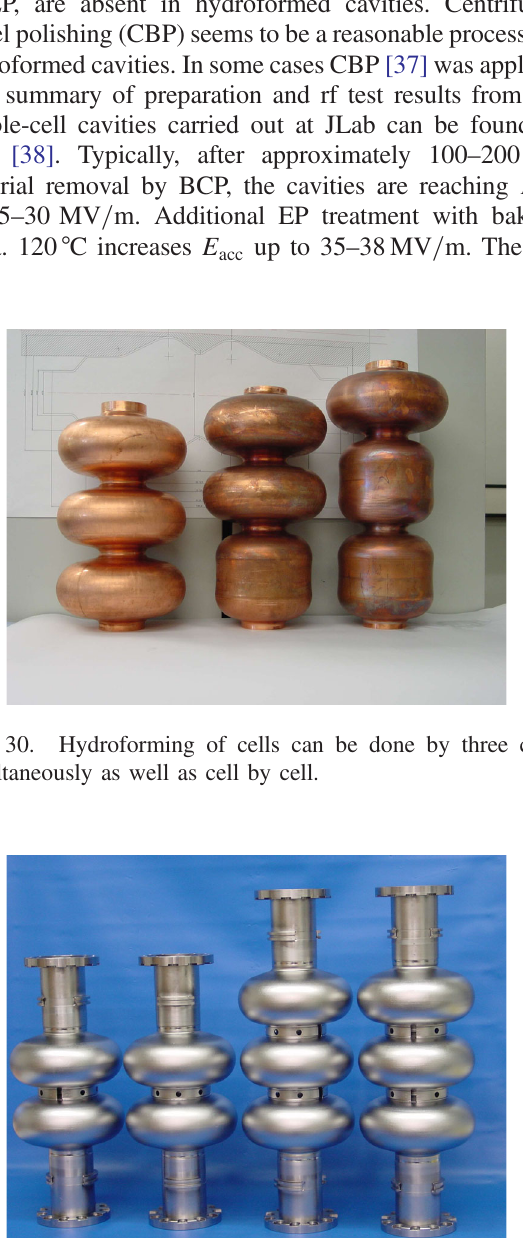
FIG. 33. Q ( E ) of three-cell hydroformed cavities after post o acc purification at 1250 °C. The total material removal is ca. 250 μ m by